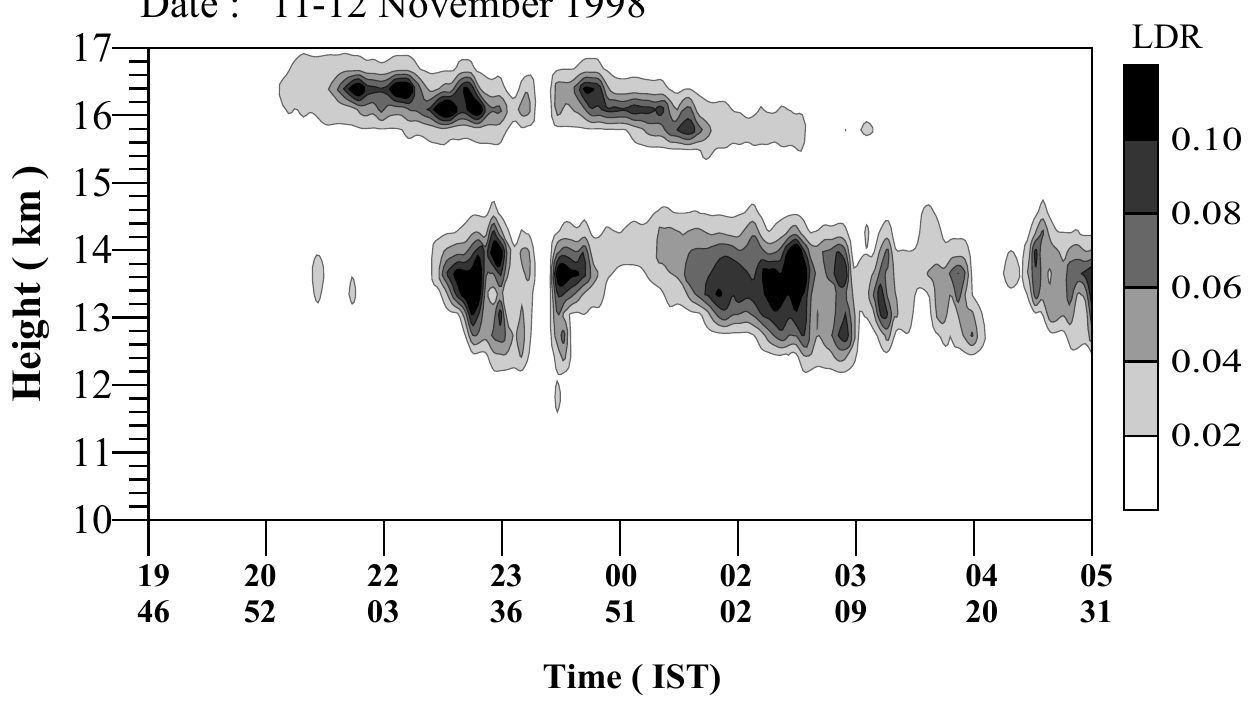
Fig. 2. A Time-Height representation of the Linear Depolarization Ratio of tropical cirrus layers observed by polarization lidar on 11–12 November